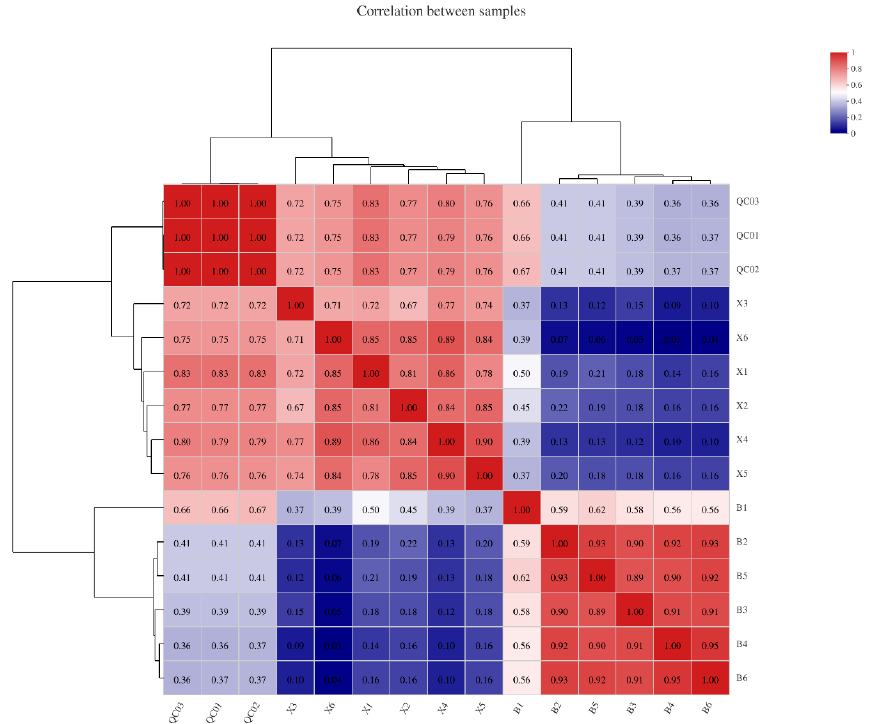
Figure 3. Sample evaluation. The abscissa is the RSD (%) value, that is, the standard deviation/mean value and the ordinate is the proportion of ion peak.